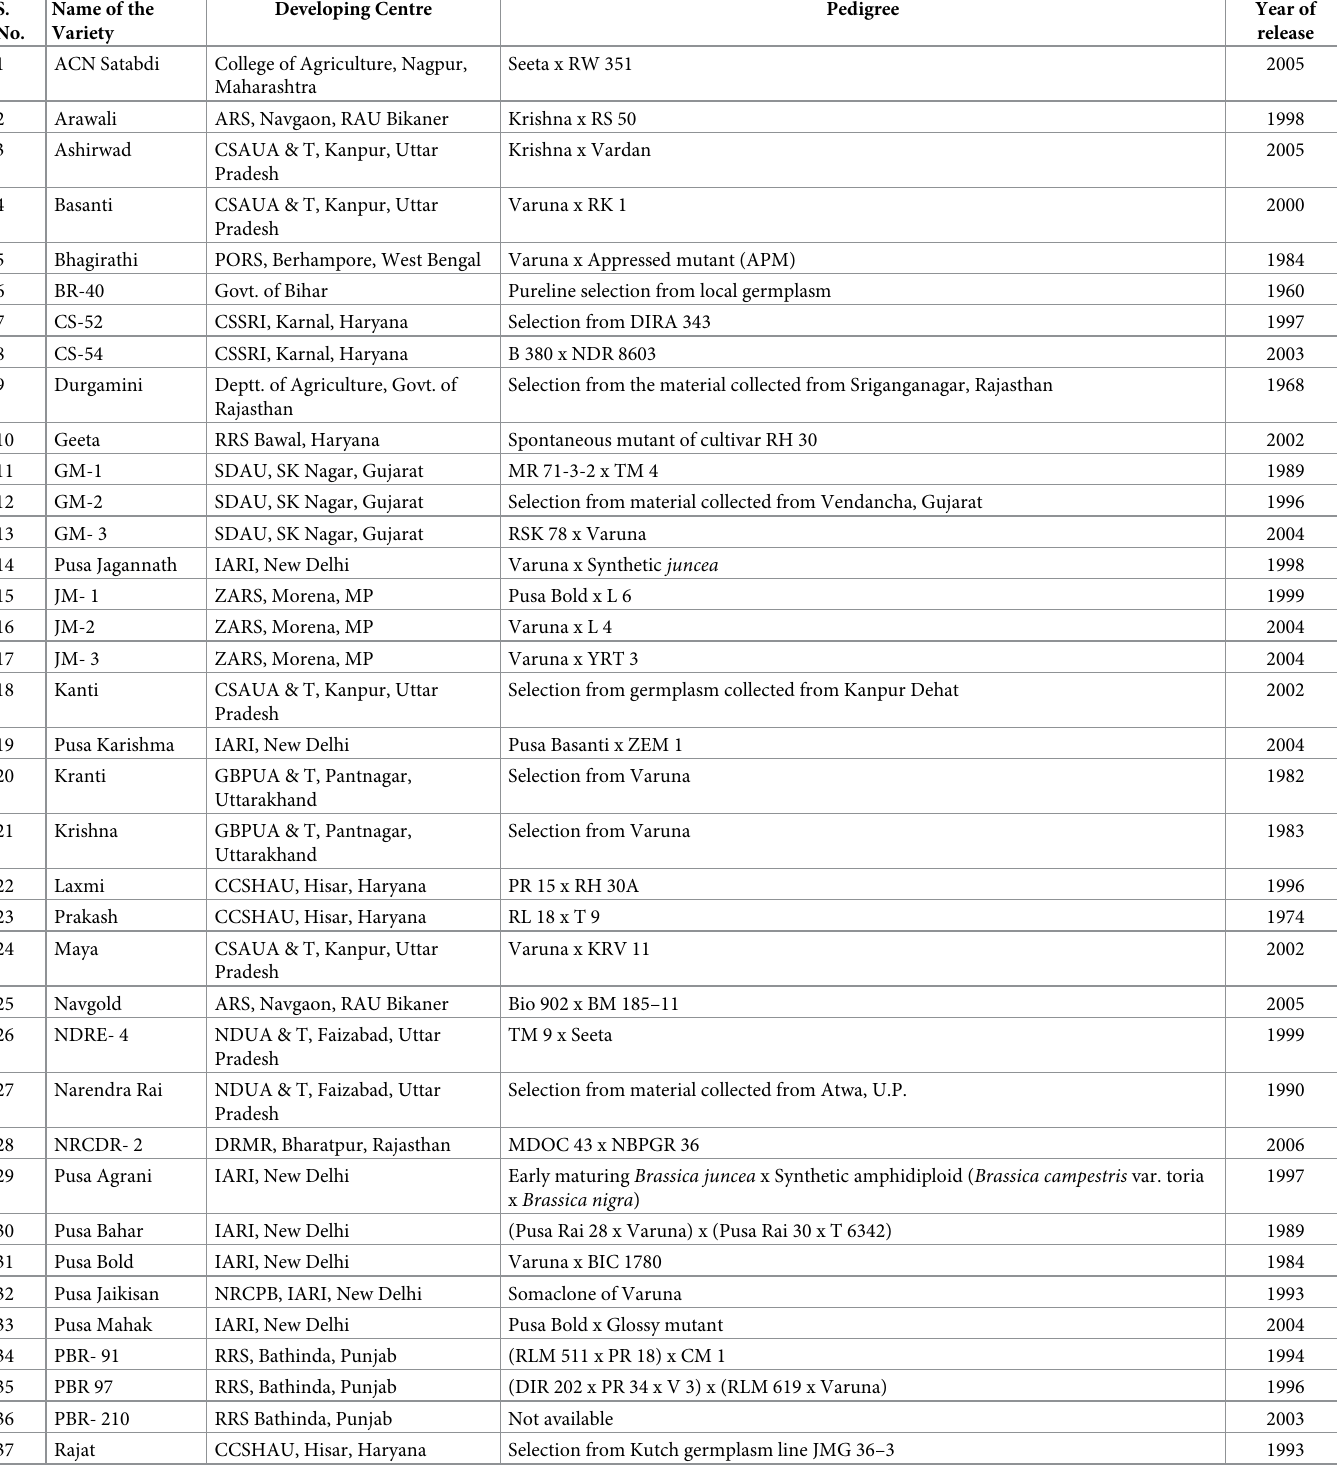
Table 1. List of B . juncea varieties used in the present investigation and their pedigree/description. S.